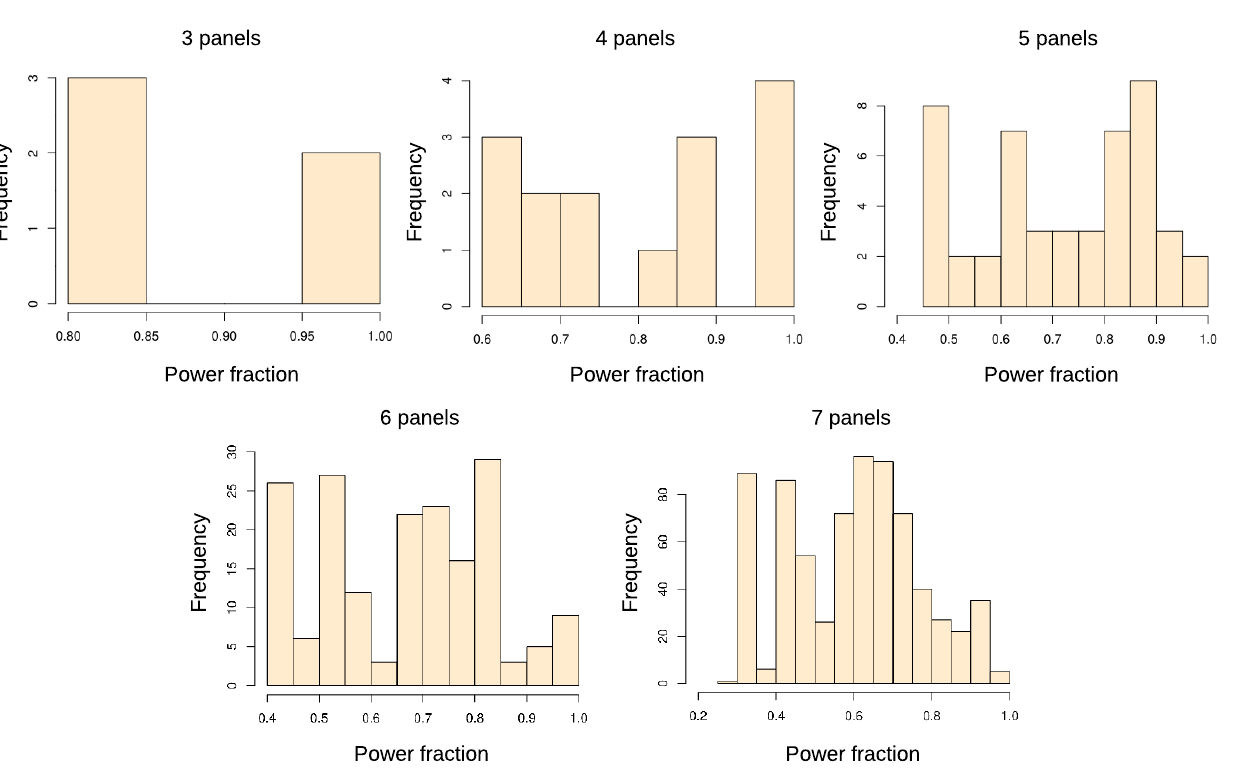
Figure 10. Histograms showing the normalized power distribution for every array-digraph ranging from 3 to 7 panels. The normalized power of a structure of p panels is the power it produces divided by the power of the array-digraph of p panels that produces the most.